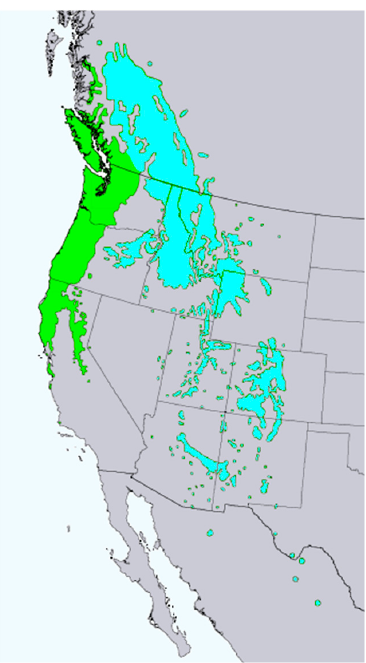
Figure 7. Natural range of Pseudotsuga menziesii glauca [6].